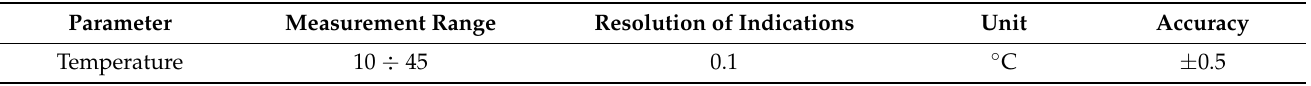
Table 2. Measurement ranges and resolution of indications. Indoor air quality monitor.